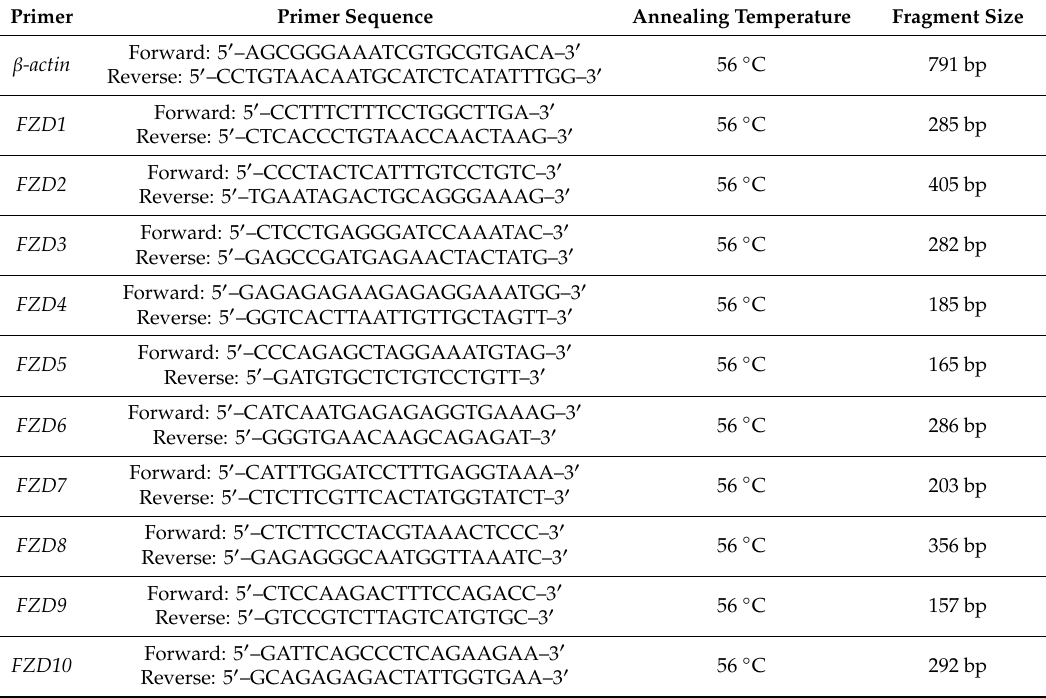
Table 3. Primer sequence, annealing temperature, and fragment size.